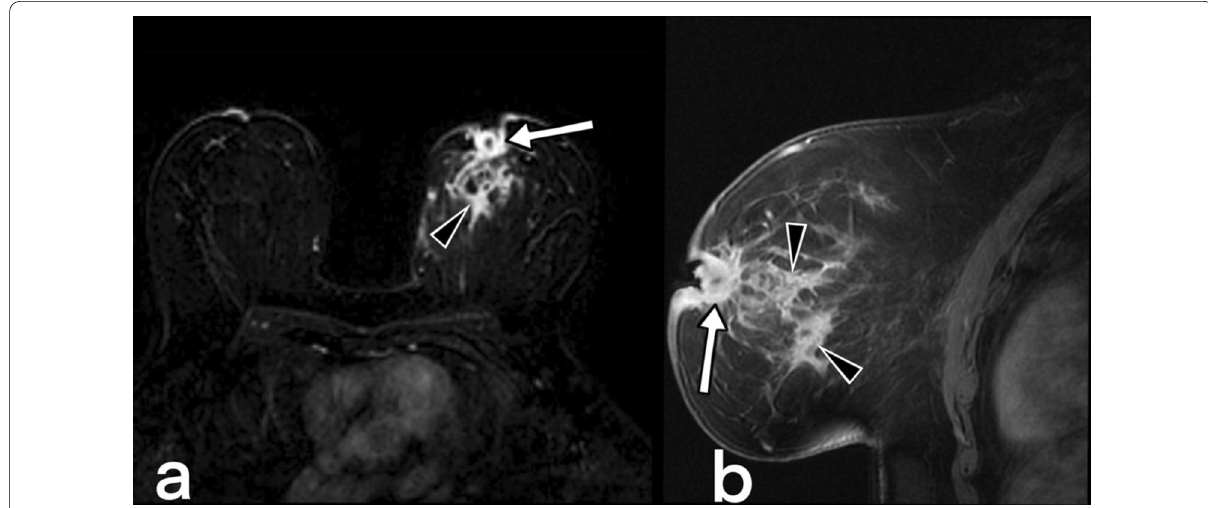
Fig. 11 MRI images of a 37-year-old female. Axial ( a ) and sagittal ( b ) fat-suppressed T1 weighted contrast-enhanced images demonstrate nodular tuberculosis in the left breast. MR image shows an irregular shaped spiculated margins mass (arrowheads) with heterogeneous internal enhancement. The lesion mimics a breast carcinoma with nipple retraction (arrows). BIRADS 5